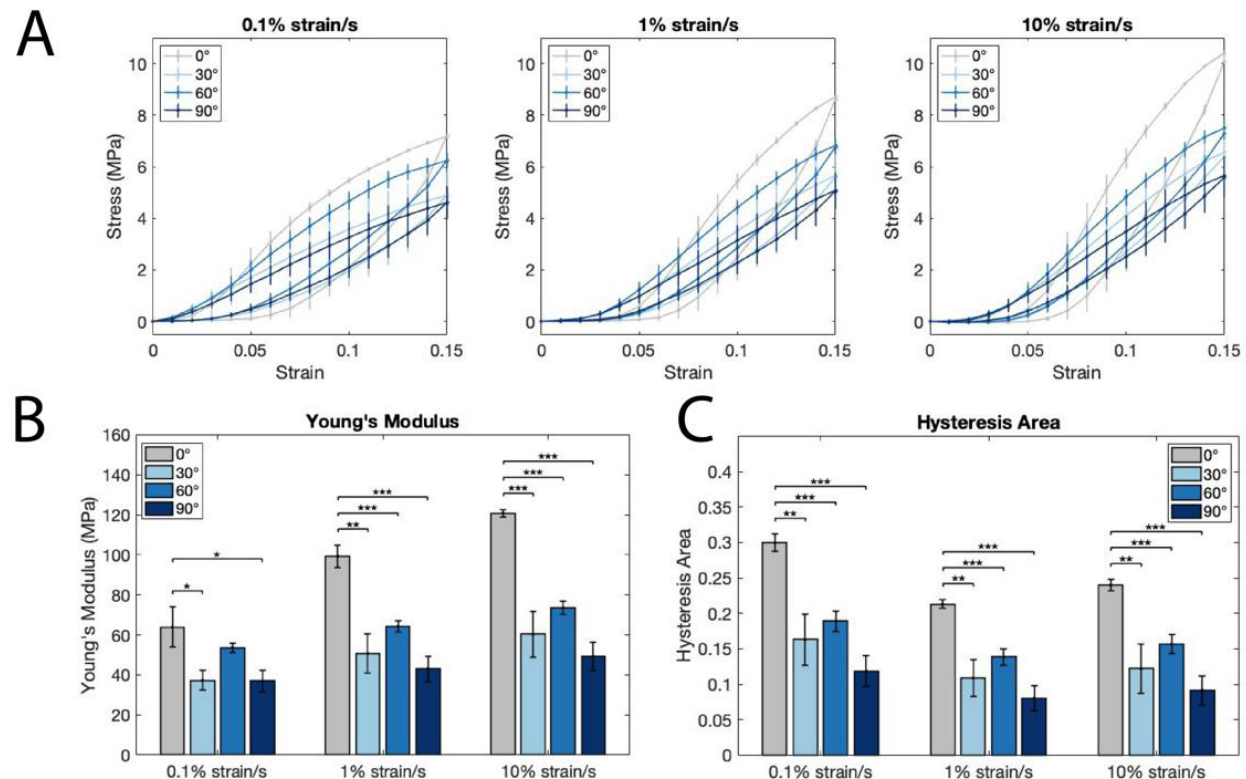
Figure 4. Mechanics of large diameter acellular scaffolds show strain-rate dependence and energy loss lessened with angled vs. parallel fibers. ( A ) Stress–strain curves generated from cyclic tensile testing of scaffolds at strain rates of 0.1, 1, and 10 percent strain/second. ( B ) Young’s modulus of 0 ◦ , 30 ◦ , 60 ◦ , and 90 ◦ scaffolds at three different strain rates. ( C ) Hysteresis of 0 ◦ , 30 ◦ , 60 ◦ , and 90 ◦ scaffolds, calculated as the area between the loading and unloading curves for the three strain rates (*, **, and *** indicate p ≤ 0.05, 0.01, and 0.001, respectively). Additionally, the lower hysteresis in the 30 ◦ , 60 ◦ , and 90 ◦ scaffolds suggests that